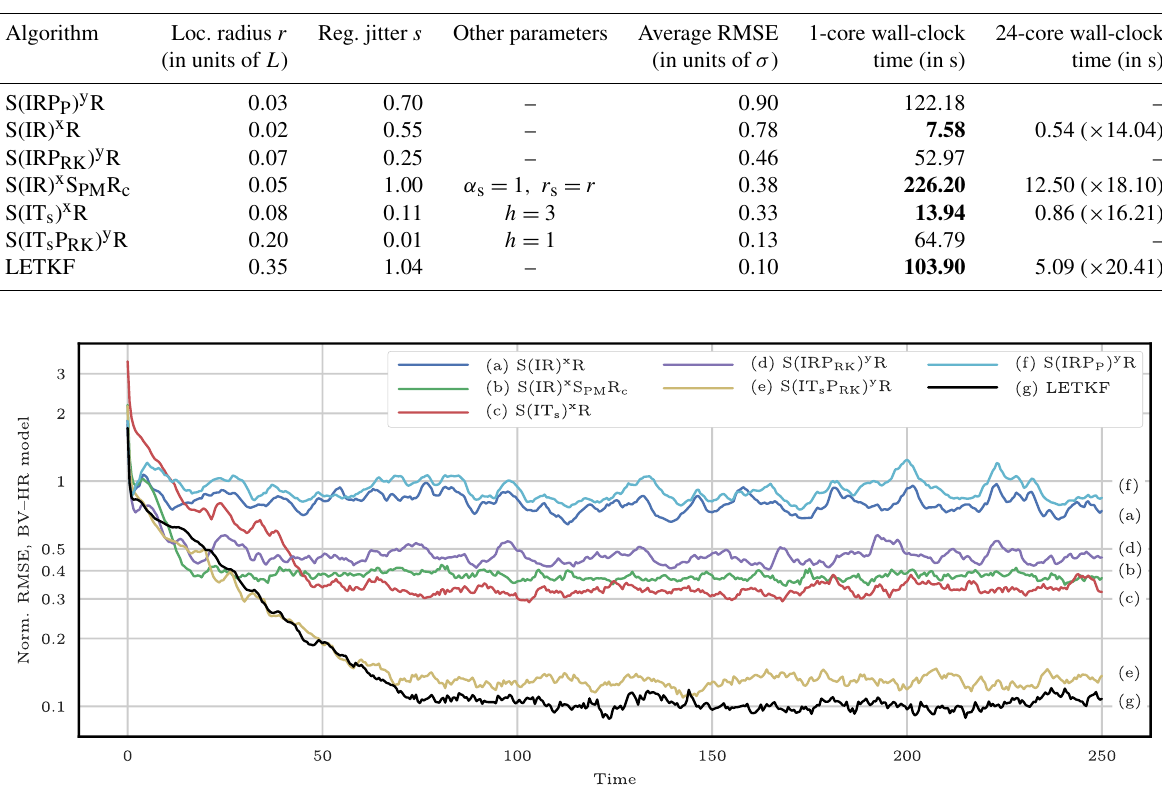
Figure 22. Instantaneous analysis RMSE for the selection of algorithms detailed in Table 5. The scores are displayed in units of the observa- tion standard deviation σ